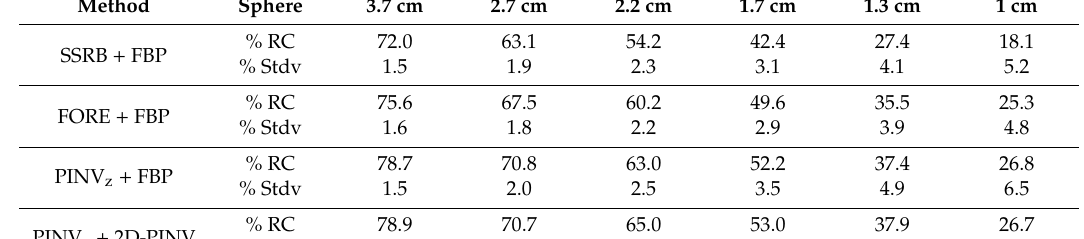
Table 2. Recovery Coe ffi cients (RC) and noise for the clinical IQ NEMA phantom (NEMA NU 2-2017).